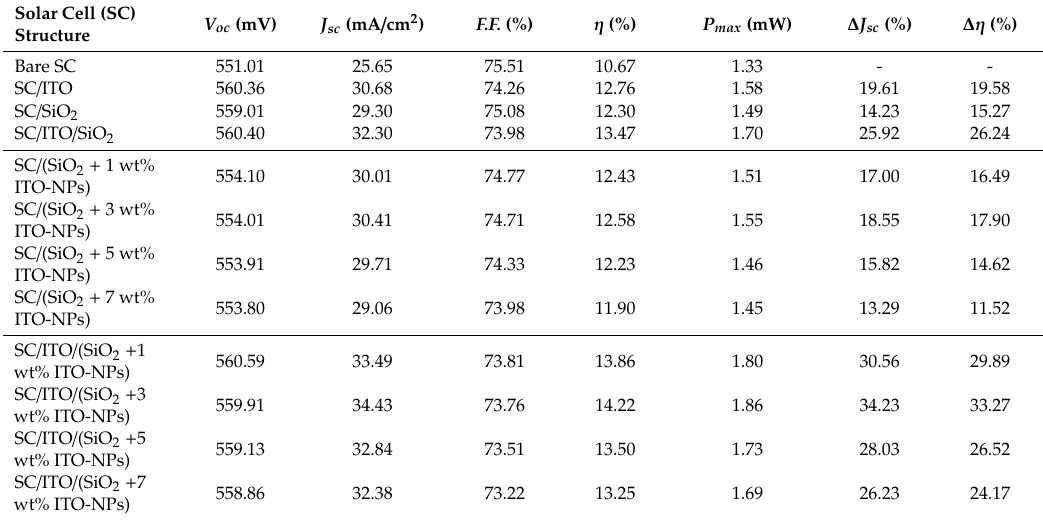
Figure 8. Optical reflectance spectra and external quantum efficiency (EQE) responses of the bare silicon solar cell, the solar cell with a SiO 2 layer, and the solar cell with an ITO layer. Table 3. Photovoltaic performance of all fabricated cells.